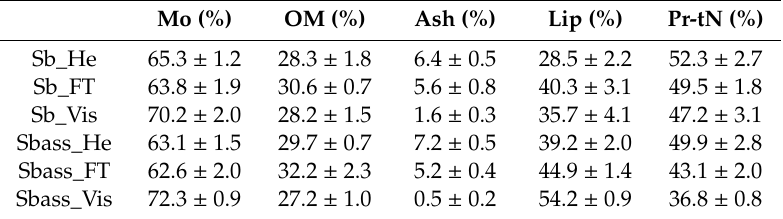
Table 1. Proximate composition of Sb and Sbass by-products in terms of moisture (Mo), organic matter (OM) and ashes (Ash). Total lipids (Lip) and proteins (Pr-tN, as total nitrogen × 6.25) were determined using dried substrates. Errors are the confidence intervals for n = 2 (independent samples) and α =